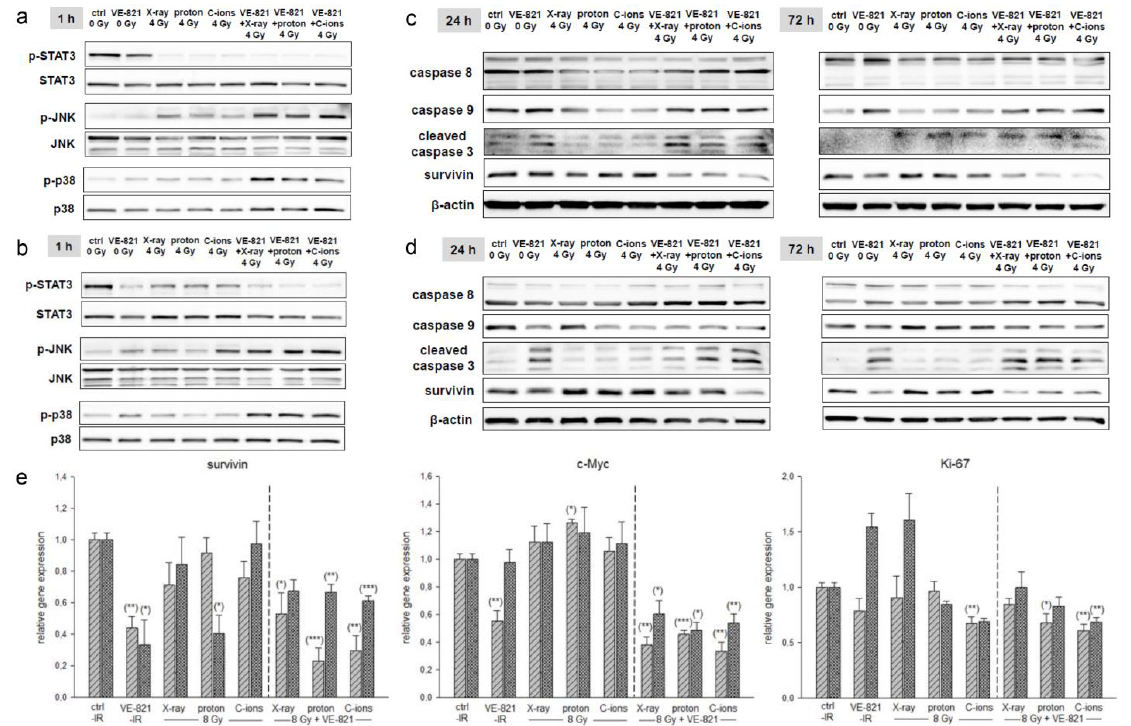
Figure 5. MAPK phosphorylation and the expression of apoptotic markers. p-STAT3, p-JNK, and p-p38 protein phosphorylation pattern of ( a ) SW-1353 and ( b ) Cal78 chondrosarcoma cells 1 h after